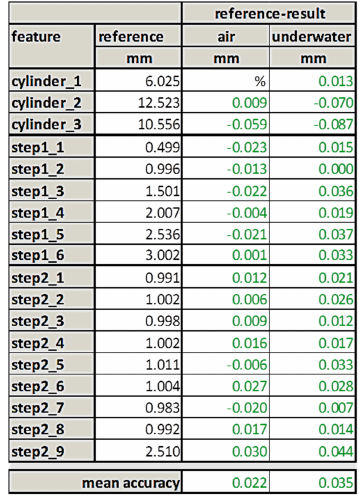
Table 9. Measurement of the contour artefact: results in air compared to results in pure water